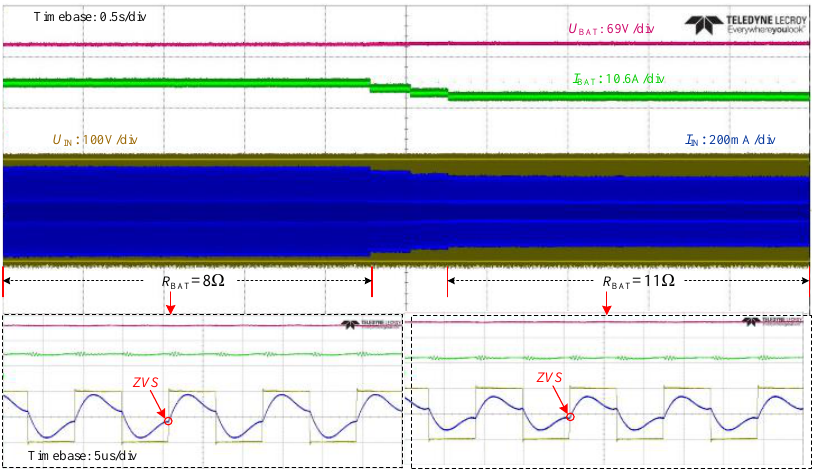
Figure 17. Experimental waveforms of U BAT , I BAT , U IN , and I IN in the LCC-S topology.